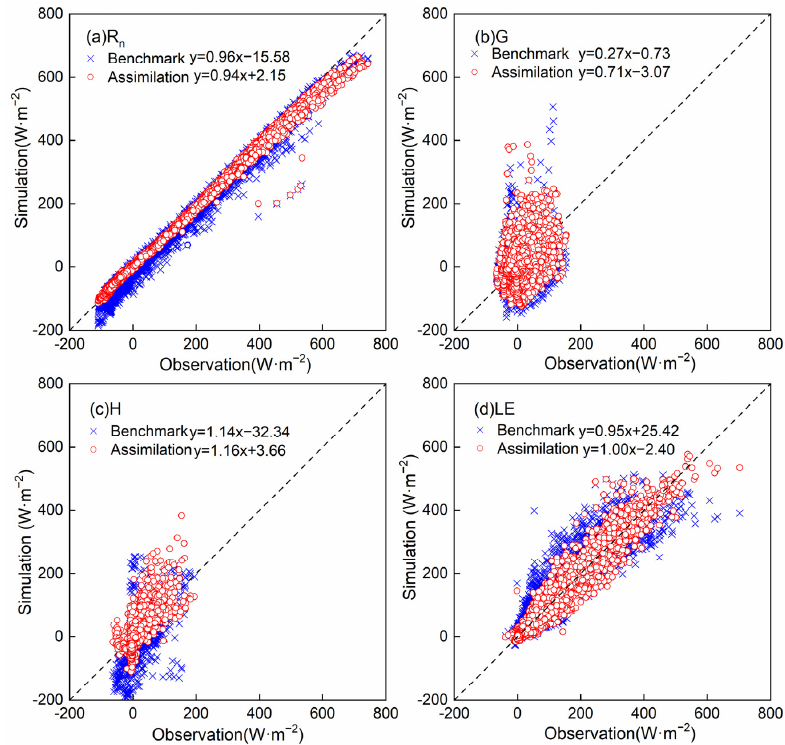
Figure 7. Scatter plots of surface flux simulation compared with observation by benchmark run and data assimilation run during wheat growing season.